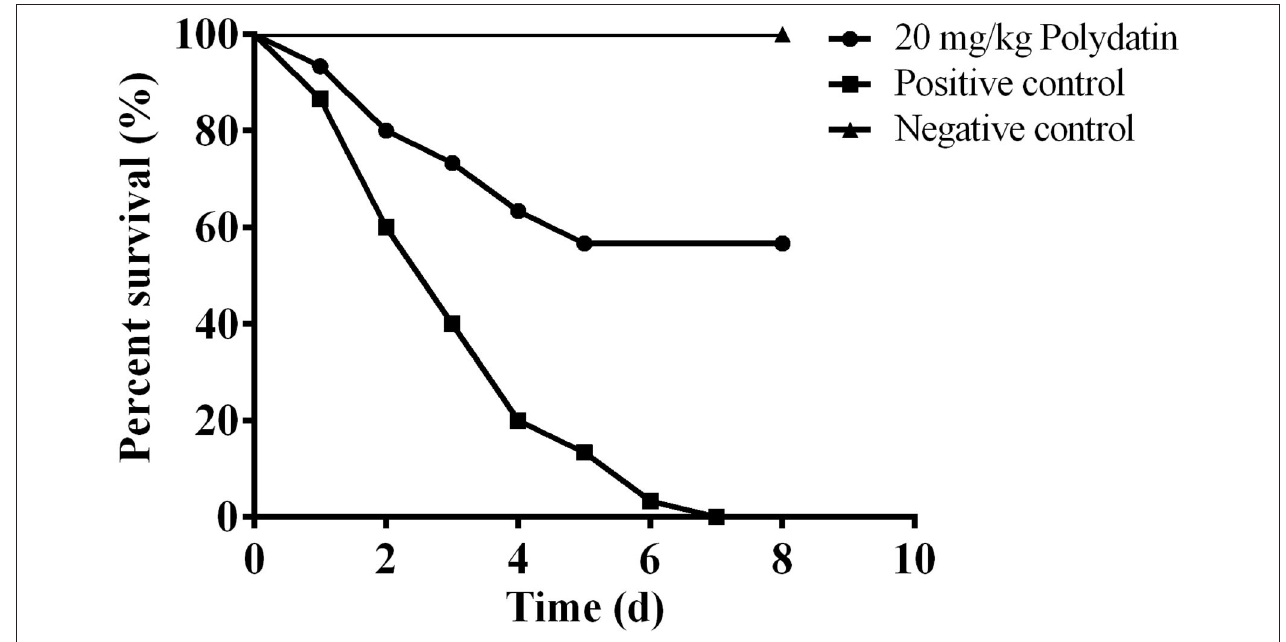
FIGURE 4 | The survival percentage of channel catfish challenged with Aeromonas hydrophila (A. hydrophila) and treated with or without polydatin. The survival rates of each group were analyzed by log-rank test, and the statistical significance ( p = 0.0,003) was observed.